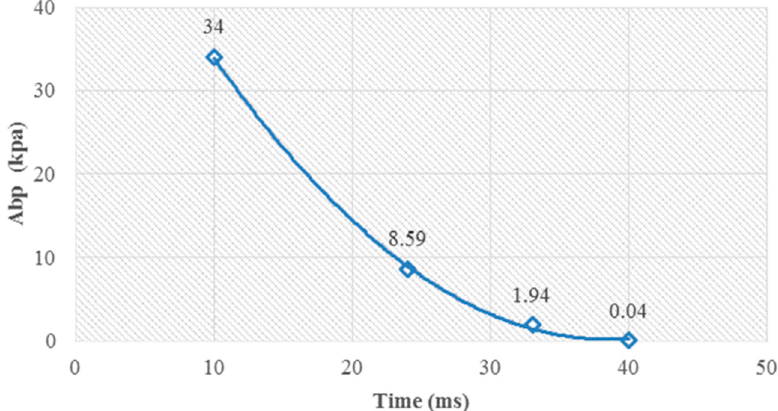
Figure 7. The relationship between Abp and time at the speed of 20 km / h.